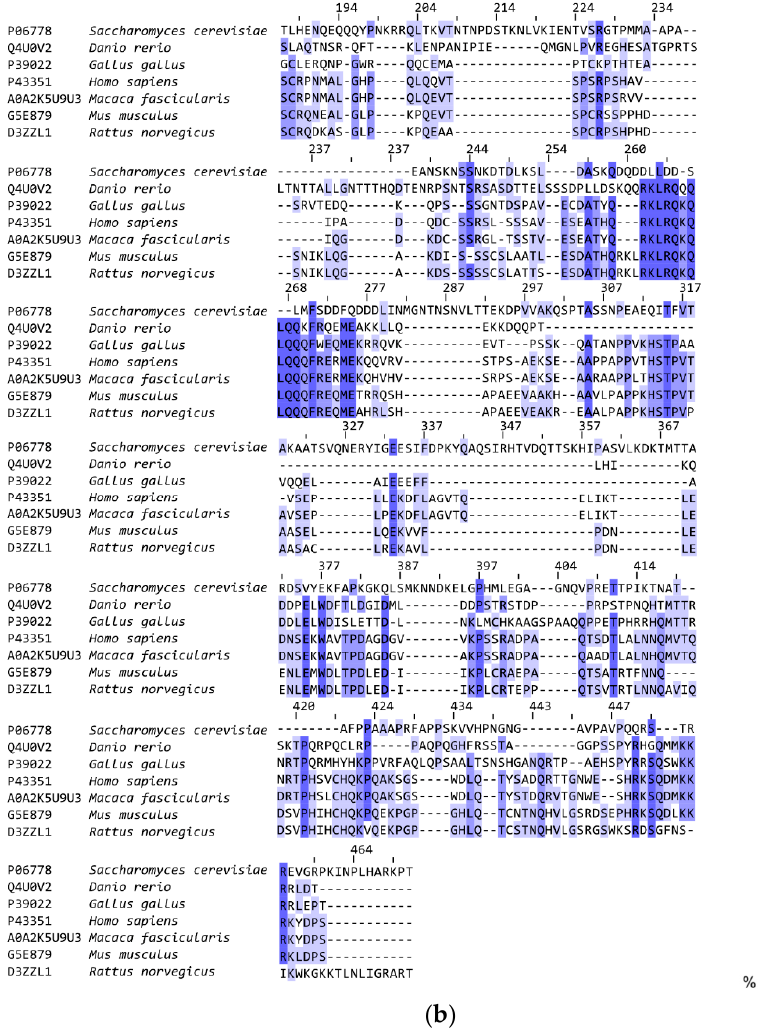
Figure 4. Multiple alignments of RAD52 sequences. ( a ) Alignment of N-terminal and ( b ) C-terminal domain sequences of different organisms. In contrast to the N-terminal domain, the C-terminal domain is not